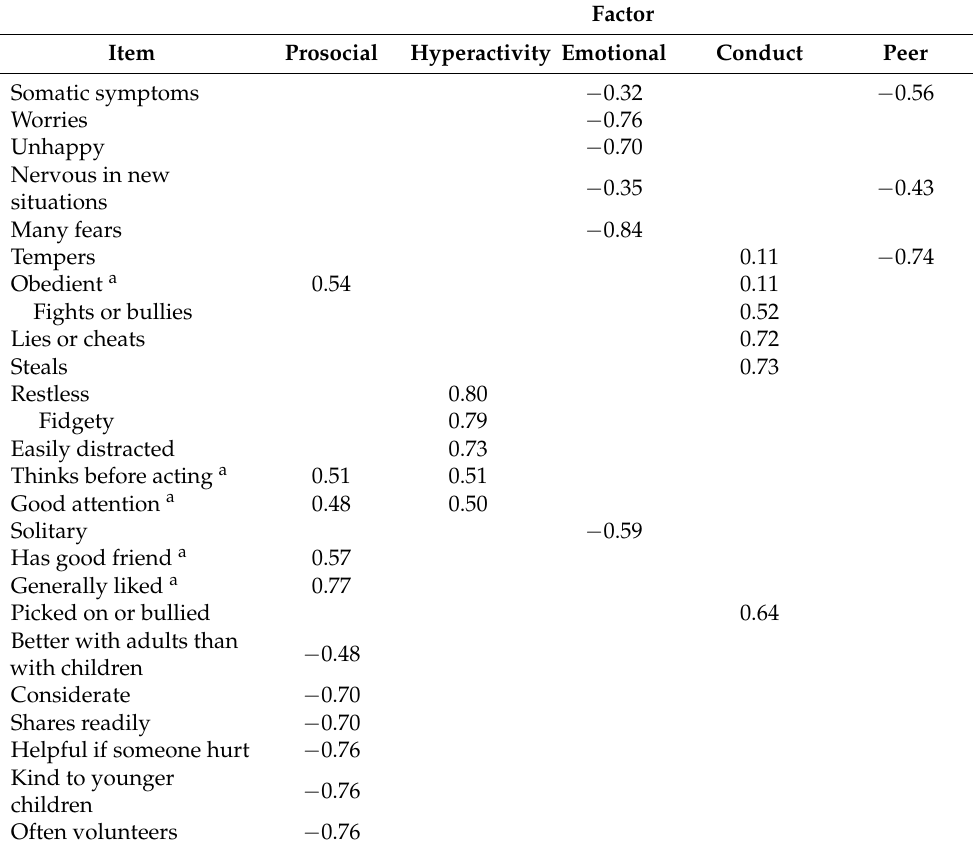
Table 5. Extracted Factors and Loadings.